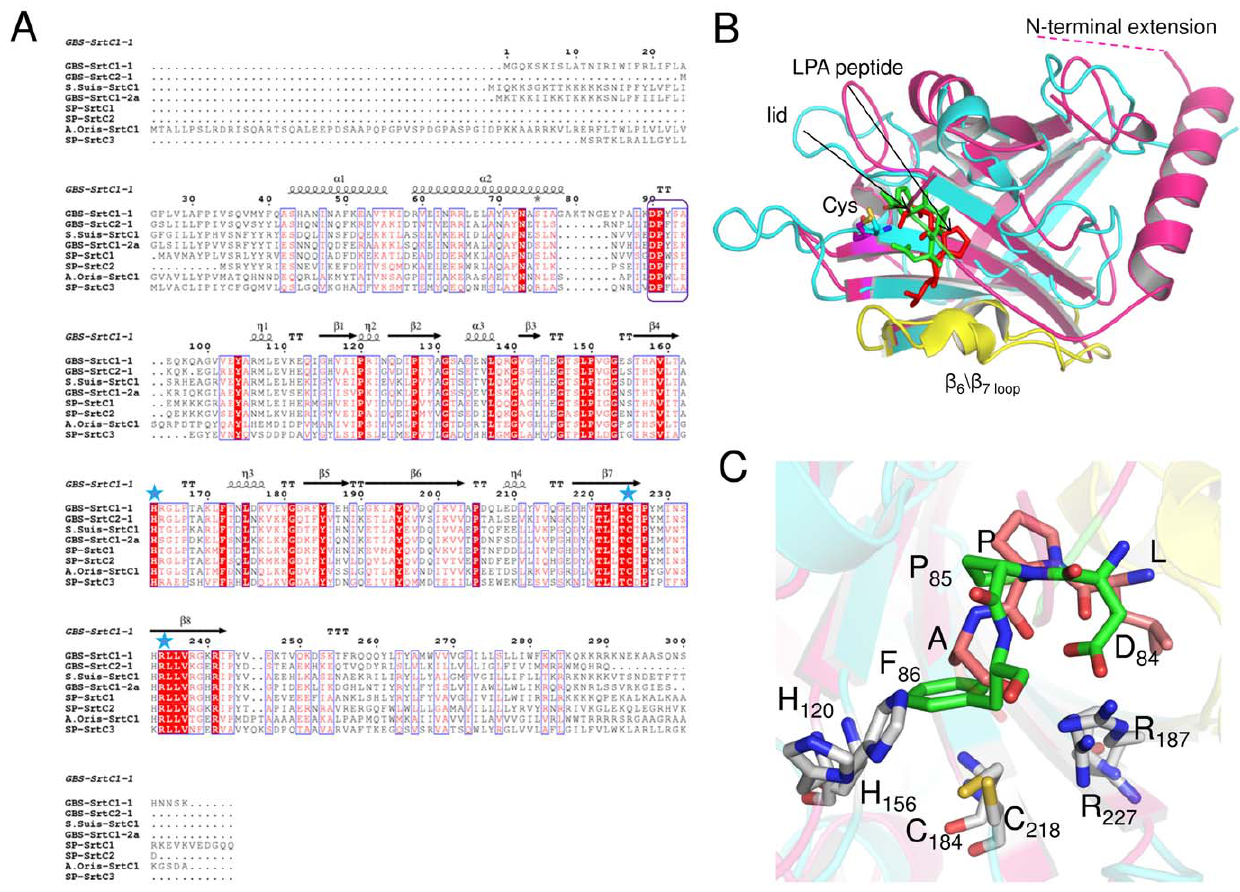
Figure 2. Structural comparison of GBS PI-1 SrtC2 crystal structure with S.aureus SrtA NMR structure. (A) Multiple sequence alignment of the pilus-forming sortases crystallized so far. Structure-based sequence alignment of the GBS PI-1 SrtC2, SrtC1, GBS PI-2a SrtC1 (PDB 3O0P), S. pneumoniae sortase C1 (PDB 2W1J), sortase C2 (PDB 3G69), sortase C3 (PDB 2W1K), S. suis SrtC1 (PDB 3RE9) and A. oris SrtC1 (PDB 2XWG). Identical residues are shown with a red background, whereas similar residues are shown in red and highlighted with blue boxes. Residues located within the active site cleft are conserved among all sortases and are highlighted with blue stars, whereas the lid residues DPF\Y\W are highlighted with a purple box (http://espript.ibcp.fr/ESPript/ESPript/). (B) Superposition of GBS PI-1 SrtC2 (pink) with the S. aureus SrtA (cyan, PDB 2KID) in complex with the sorting signal analogue LPAT* (red). The b 6/ b 7 loops are colored in yellow. Unique structural features of SrtC enzymes are the N-terminal extension and the flexible lid (with the DPF motif in green as stick representation). The catalytic cysteine residues are highlighted in yellow and shown in a stick representation. The apo-SrtC2 structure overlaps with the structure of peptide-bound SrtA with an overall Ca rmsd of 2.33 A˚ for 118 aligned residues. (C) The lid residues DPF (color, Asp84, Pro85, Phe86) of GBS pilus-forming sortase is located analogously to the LPA substrate peptide (shown in sticks where carbon, oxygen, and nitrogen atoms, are depicted as white, red, and blue, respectively) in the structure of SrtA.